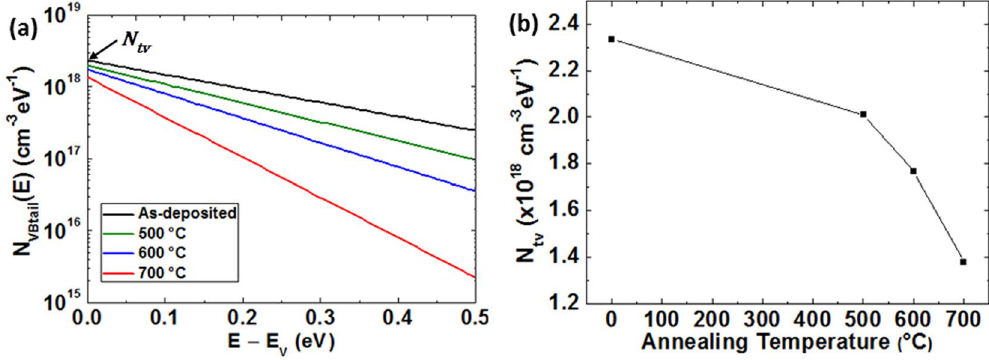
Figure 1. ( a ) Extracted density of tail states at the valence band ( N VBtail ( E )) and ( b ) tail state density at E = E V ( N tv ) of Cu 2 O films before and after